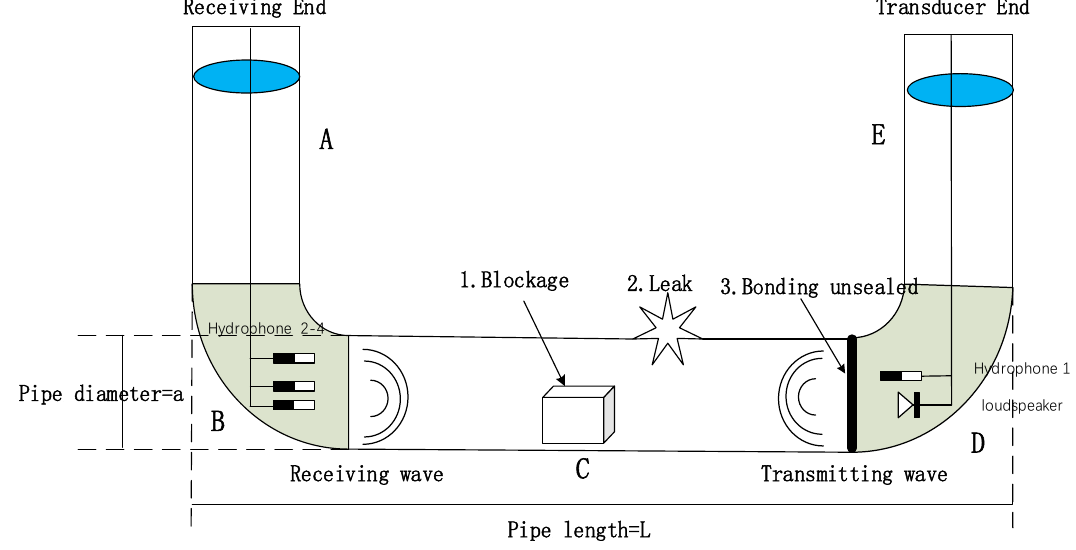
Figure 1. Acoustic wave detection in the siphon.